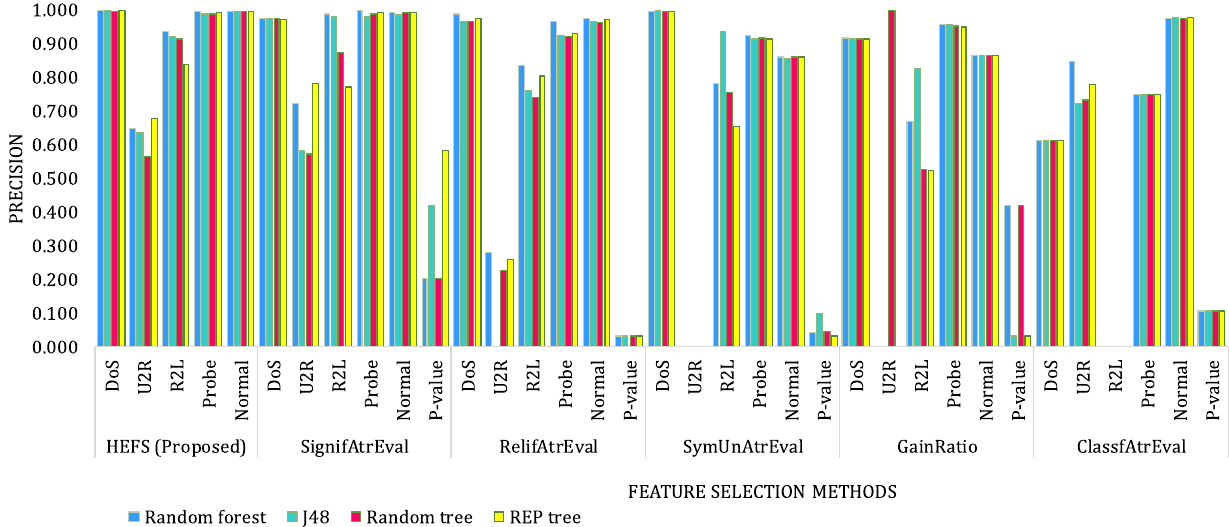
Fig. 4 The performance of the HEFS and base feature selection methods for detecting DoS, U2R, R2L, probe, and normal classes in terms of precision with their P values Table 5 Performance evaluation of HEFS method in terms of DR and Acc with the four classifiers